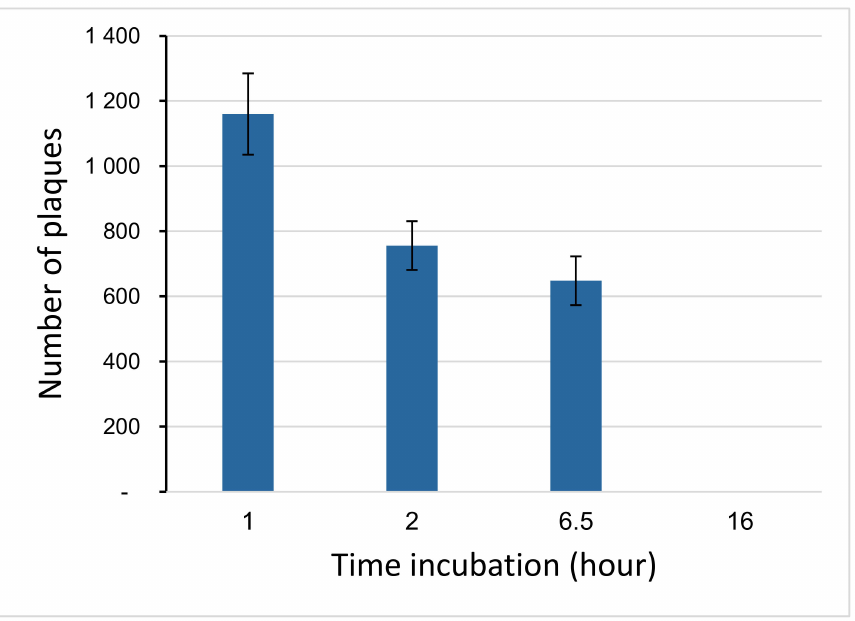
Figure 4. Survival of bacteriophage in proteolytic enzyme depending on the incubation time.